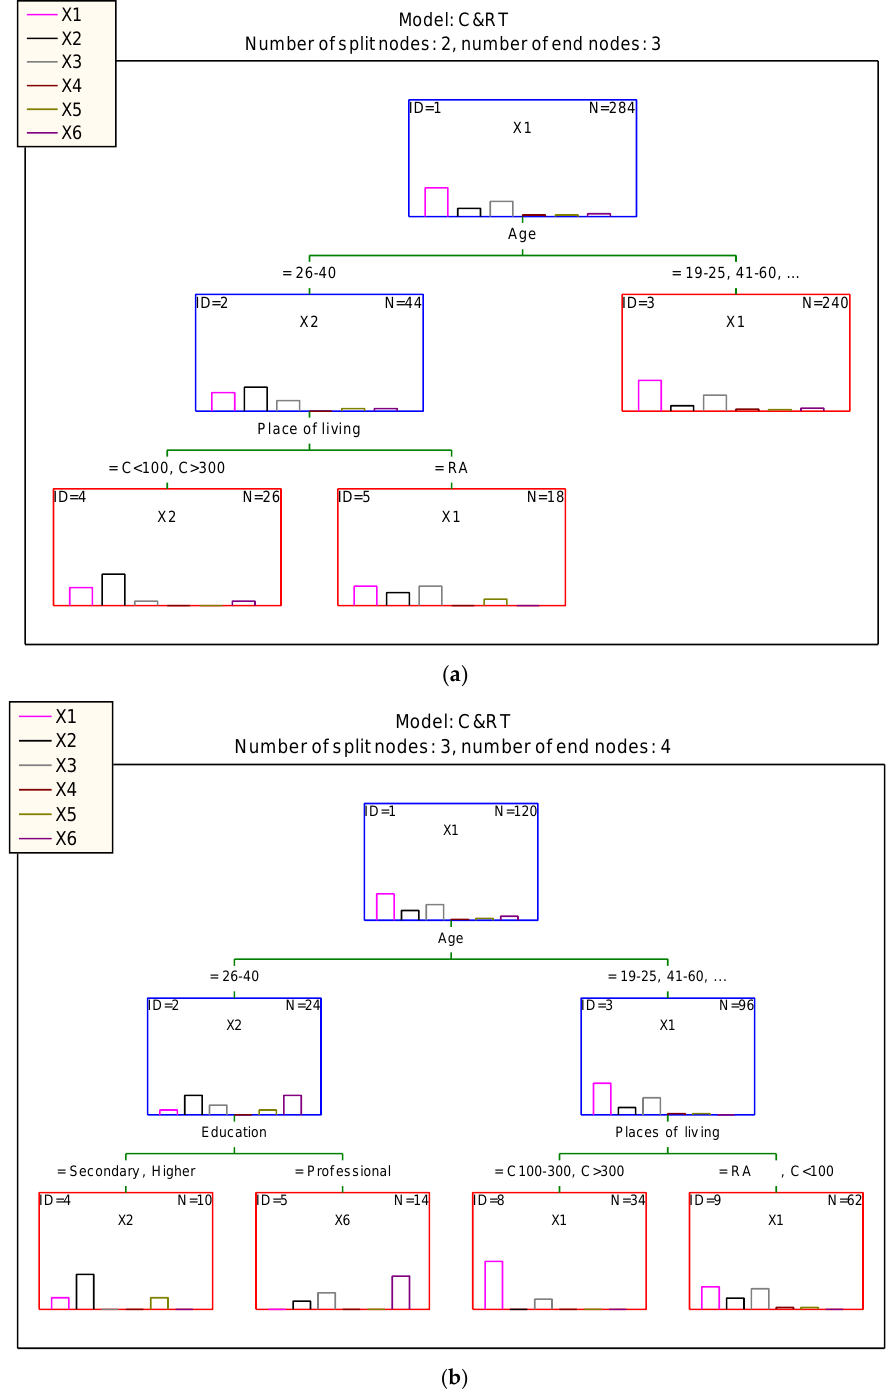
Figure 4. ( a ). Classification trees for rules regarding purchases by women. Abbreviations: X1-hypermarket, X2-via internet, X3-local store, X4-wholesale, X5-farmer, X6-marketplace, Age: 19 – 25 years, 26 – 40 years, 41 – 60 years, more than 60 years, place of living: RA-rural, C100-city with up to 100,000 residents, C100 – 300-city with 100,000 – 300,000 residents, C > 300-city with more than 300,000 residents. ( b ). Classification trees for rules regarding pur- chases by men. Abbreviations: X1-hypermarket, X2-via internet, X3-local store, X4-whole- sale, X5-farmer, X6-marketplace, Age: 19 – 25 years, 26 – 40 years, 41 – 60 years, more than 60 years, place of living: RA-rural, C100-city with up to 100,000 residents, C100 – 300-city with 100,000 – 300,000 residents, C > 300-city with more than 300,000 residents, Education: Sec- ondary education, Higher education, Professional education. Figure 4a shows that three rules were created for such classifications. The final node (ID = 3) included consumers — women in the 19 – 25 and 41 – 60 years age groups — who shopped in a hypermarket and a local store.